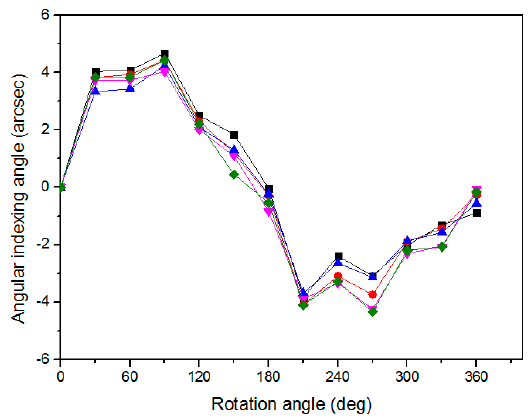
Figure 13. Repeatability plot of angular indexing error of the mandrel after a 90° shift. Table 1. Measured data of Figure 13.